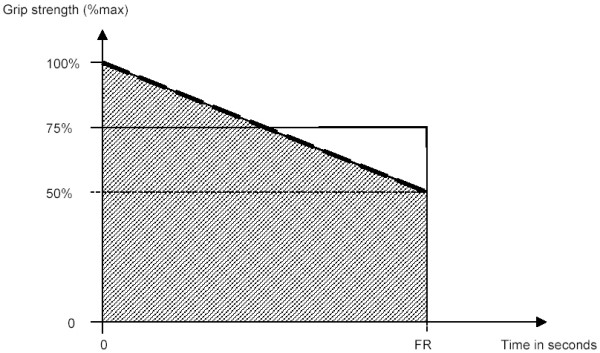
Schematic presentation of Grip Work. FR = Fatigue resistance: the time during which grip strength decreases to 50% of its maximum value. The bold line represents the estimate of the evolution of grip strength with time during sustained contraction. Grip work is calculated as FR multiplied by 75% of the maximal grip strength, corresponding to the area under the curve (shaded).